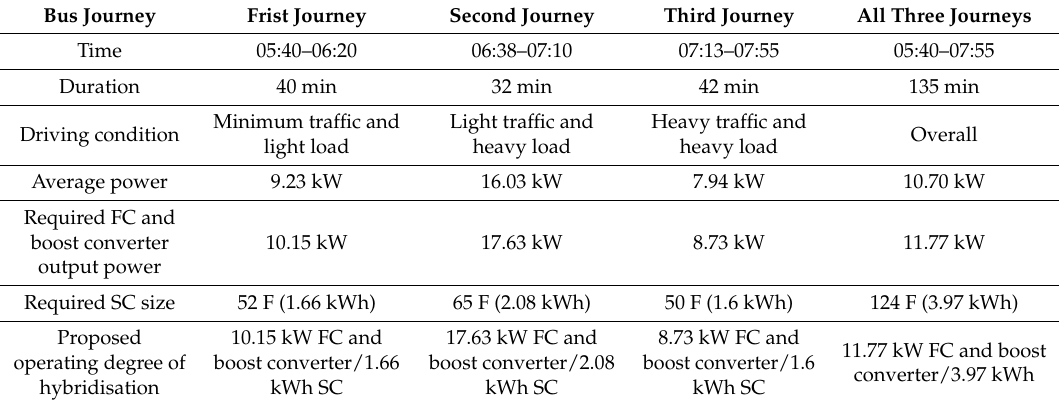
Table 2. First 135 min of route 388 24-h bus profile parameters.